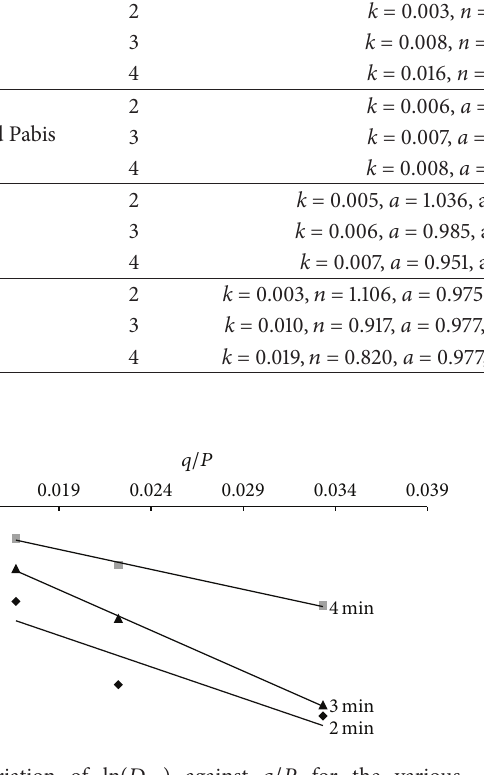
Figure 6: Variation of ln (𝐷 eff ) against 𝑞/𝑃 for the various microwave pretreatment